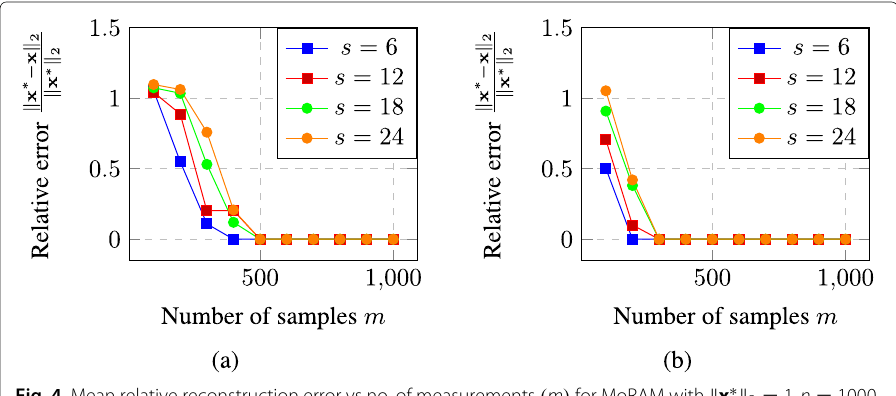
Fig. 4 Mean relative reconstruction error vs no. of measurements ( m ) for MoRAM with (cid:11) x ∗ (cid:11) 2 = 1, n = 1000, and a R = 3.2 and b R = 3.6